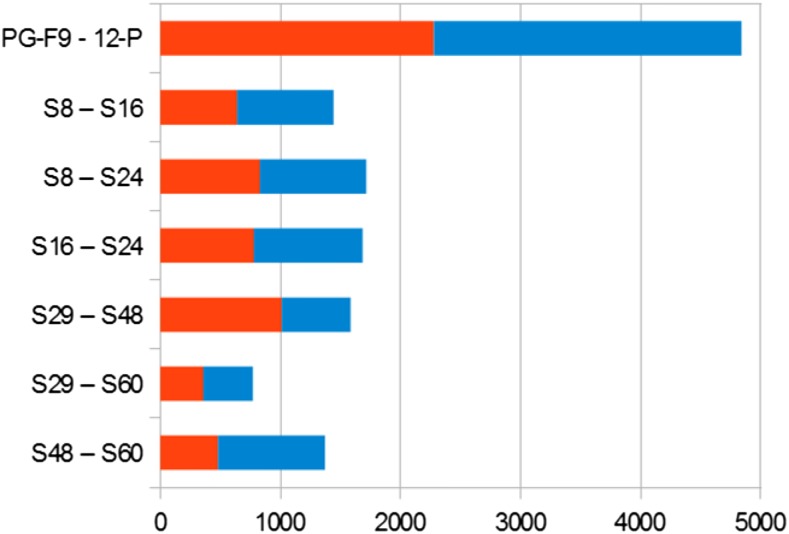
Number of differentially expressed genes in single genotype comparisons. The red bar corresponds to the genes overexpressed in the first genotype of each comparison, the blue bar to the genes overexpressed in the second genotype of each comparison.